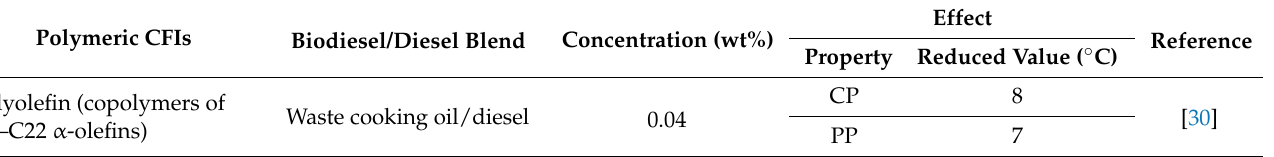
Table 8. Some polymeric CFIs for blended